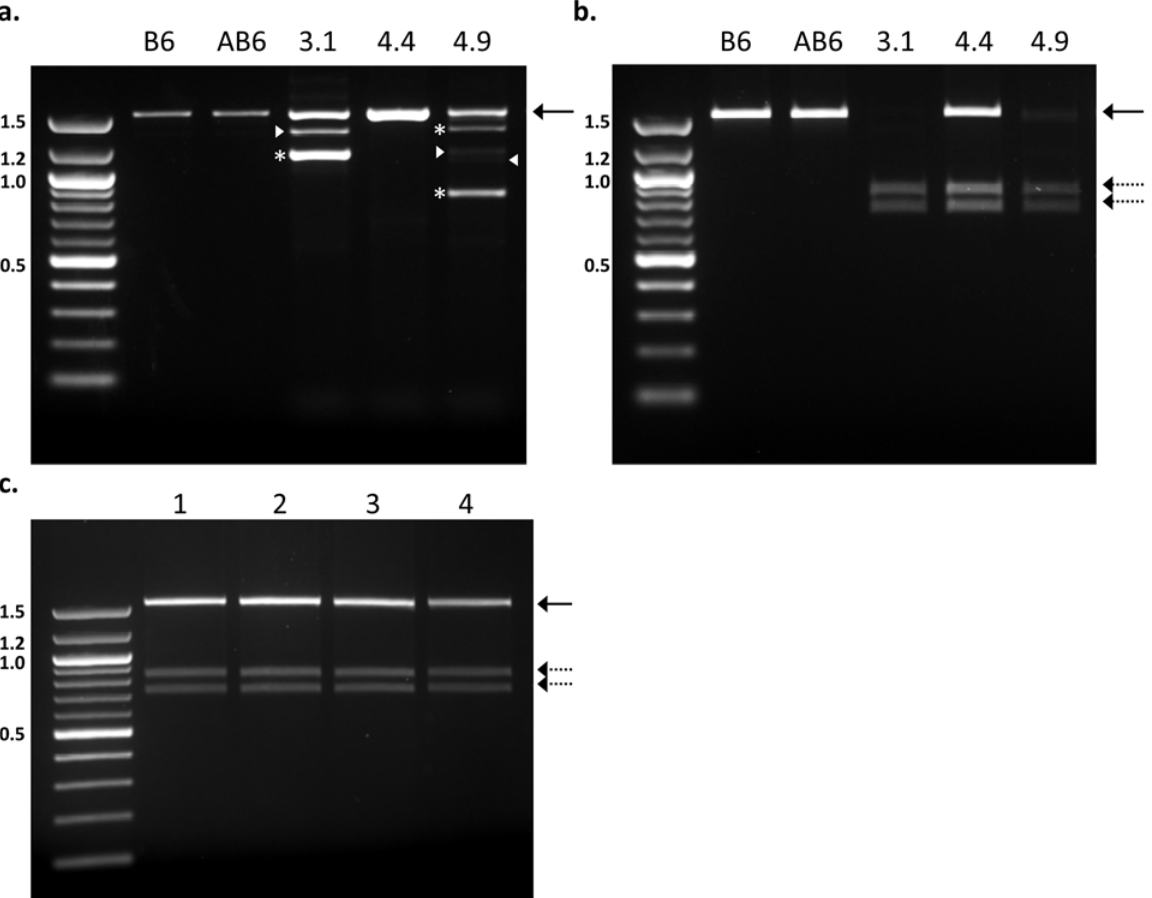
Figure 7. Homologous recombination (HR) in founder mice. (a) Genomic DNA was amplified with primers (Table 4) designed to flank the Tyr mutation site resulting in a PCR product of 1555bp (solid arrow). Amplification of mice 3.1 and 4.9 yielded multiple smaller molecular weight bands. The bands represented by asterisks have been confirmed by sequence analysis and represent an alternate truncated allele. Interestingly, the phenomenon of heteroduplex formation (arrowheads) is also evident in mice with more than one allele size. These artifacts are thought to occur upon heterologous binding of DNA strand from each allele (Thompson et al. 2002). Sanger sequencing of predicted heteroduplex bands confirmed the mixture of both higher and lower molecular weight bands in the product. To eliminate interference with the restriction analysis, the 1555bp band was excised from the gel for all of these mice and subjected to Sal I digest (b) . (c) Black-eyed progeny from mouse 4.9 all appeared to be positive for donor insertion. The predicted digestion products of 835bp and 720bp are indicated by the dashed arrow. The 100bp molecular weight marker was loaded in the left-most lane of each agarose gel with sizes as indicated (in Kb). B6: C57BL/6, AB6: C57BL/6 Albino. Mouse numbers are consistent with the